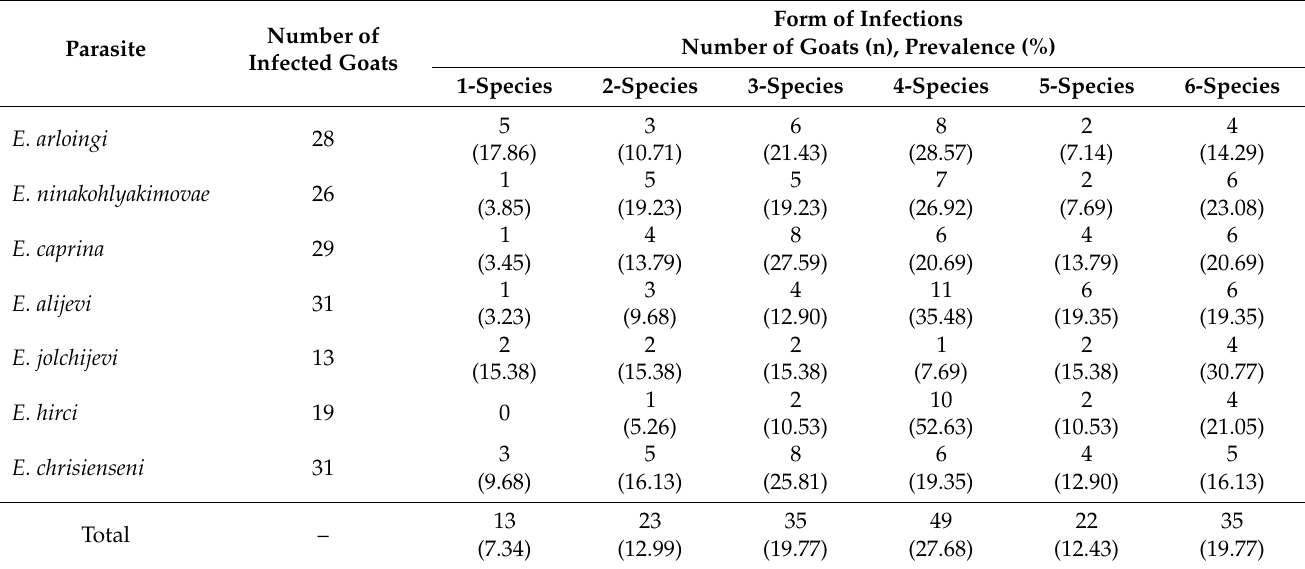
Table 4. Occurrence of particular species of Eimeria spp. in single and multi-species infections in goats on organic farms.